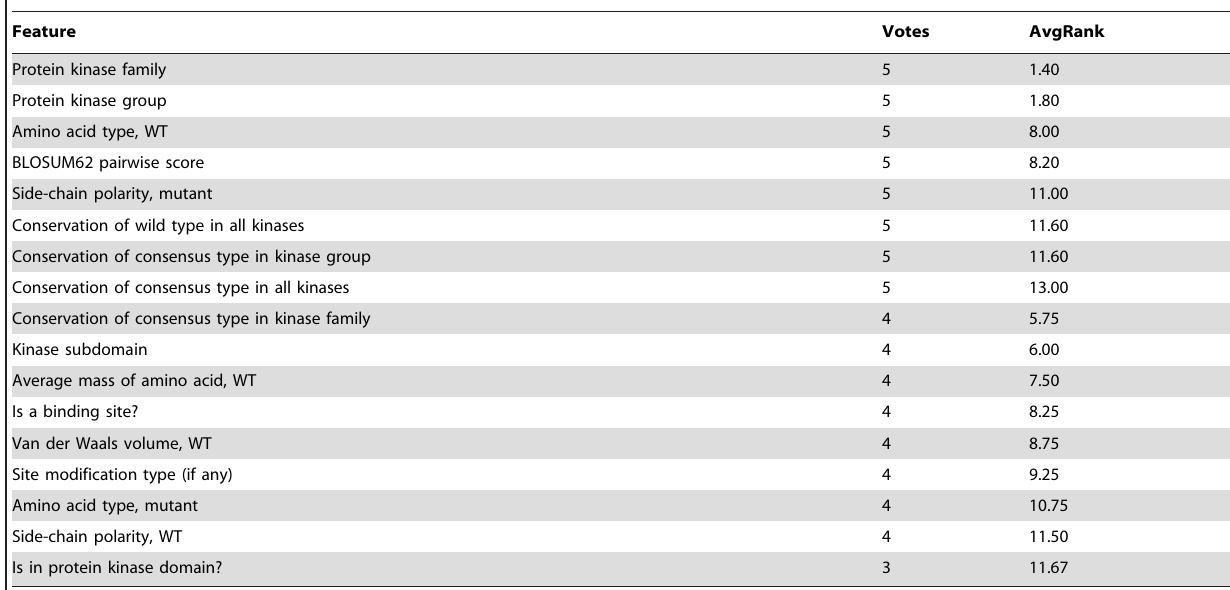
Table 1. Selected protein